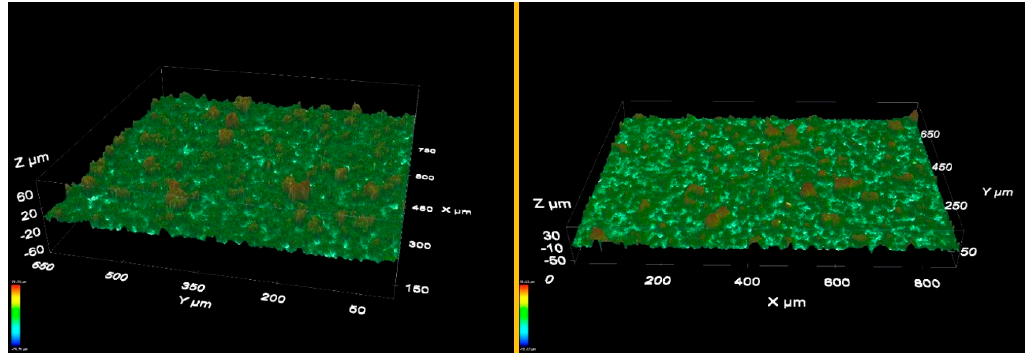
Figure 4. Three-dimensional (3D) profilometer images of a sample used for the corrosion campaign. Left—before immersion, right—after immersion.